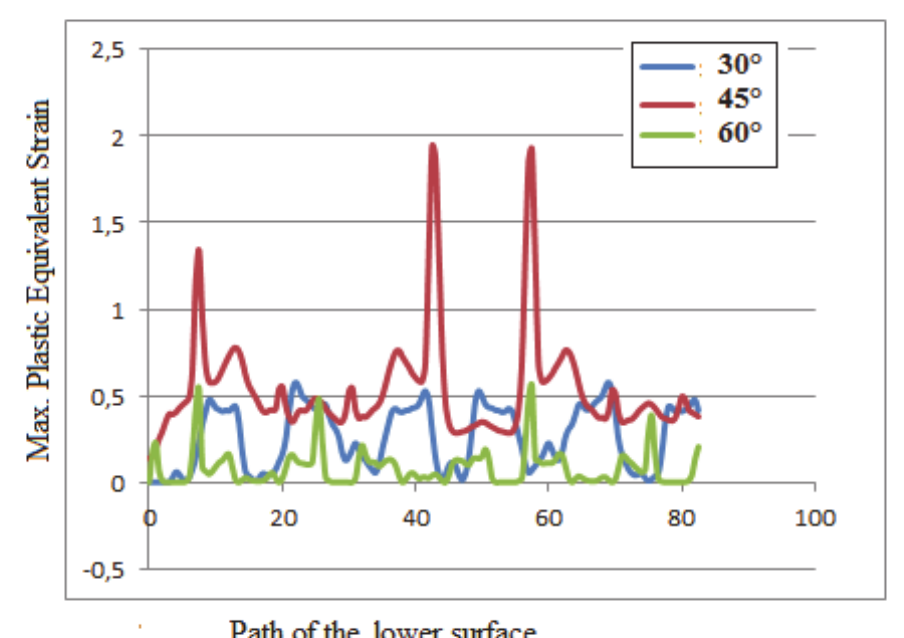
Figure 15: Evolution of the equivalent plastic strain for a path of the lower surface using different groove angles.